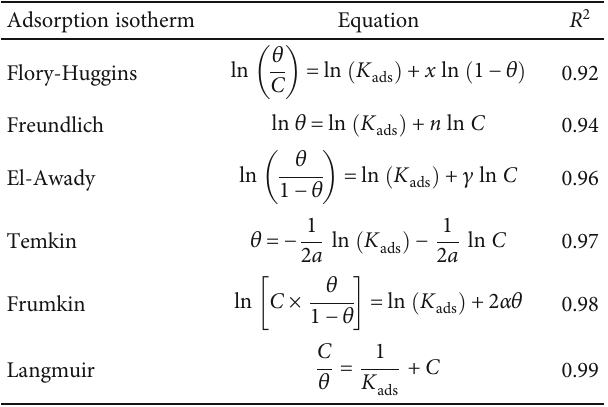
Table 4: Mathematical expression of evaluated adsorption isotherms and its corresponding calculated R 2